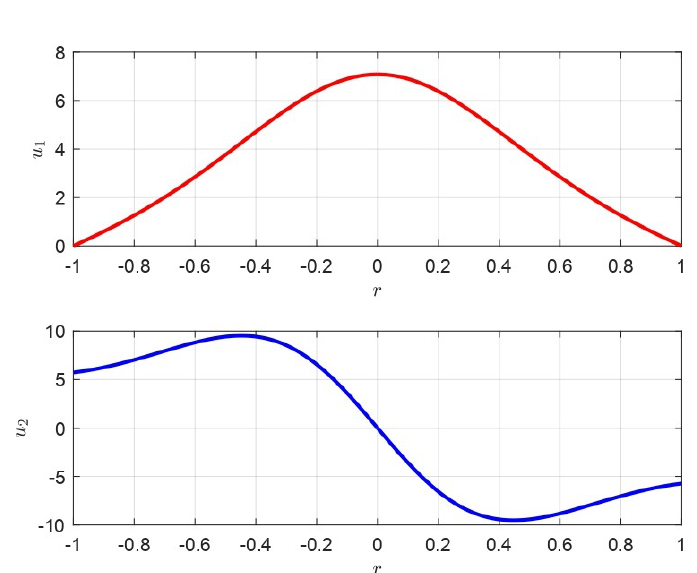
Figure 4. Recovering of the membrane by using the bvp4c MatLab R (cid:13) solver: θλ 2 = 0.5, 2.454 ≤ u 1 ≤